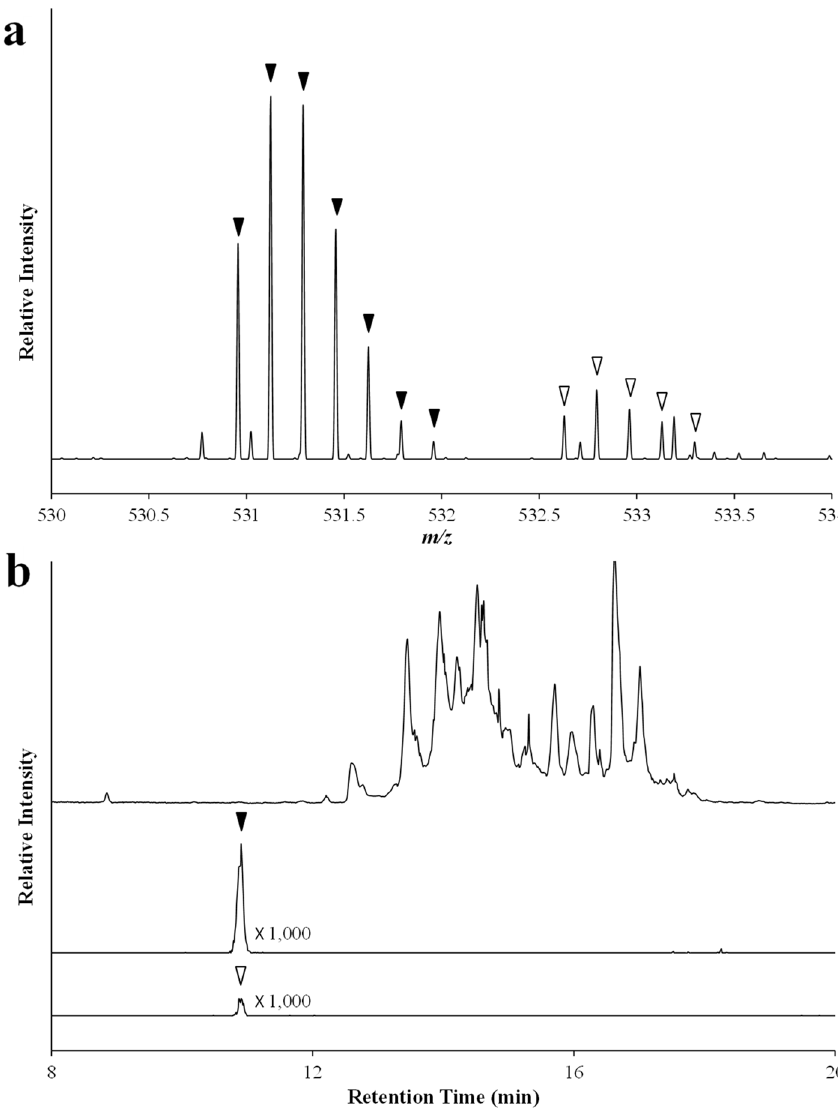
Figure 5. Quantitative analysis of the abundance of GIP_HUMAN[22–51] using LC–MS/MS. The stable isotope-labelled peptide was spiked into human plasma at the final concentration of 100 pM, enriched using the modified differential solubilisation method as described in the Methods and after desalting, the extracts derived from 10 μL plasma was analysed by LC–MS/MS. ( a ) MS spectrum of hexavalent ions observed at retention time 10.78–11.00 min (indicated by triangles in b ). Closed triangles represent those derived from the endogenous GIP_HUMAN[22–51] ( m/z = 530.9564, 531.1236, 531.2905, 531.4578, 531.6245, 531.7927, 531.9588) and open triangles from the synthetic stable isotope-labelled peptide ( m/z = 532.6279 , 532.7944 , 532.9622 , 533.1296 , 533.2957). ( b ) Comparison of the total ion chromatogram (upper panel) and hexavalent ion XICs with ± 3 ppm mass window of the endogenous (middle panel) and stable isotope-labelled peptide (lower panel). Total XIC area, defined as the sum of three ion precursors; monoisotopic mass (M), XICs of the first isotope peak (M + 1) and the second isotope peak (M + 2), was used to extrapolate plasma GIP_HUMAN[22–51]